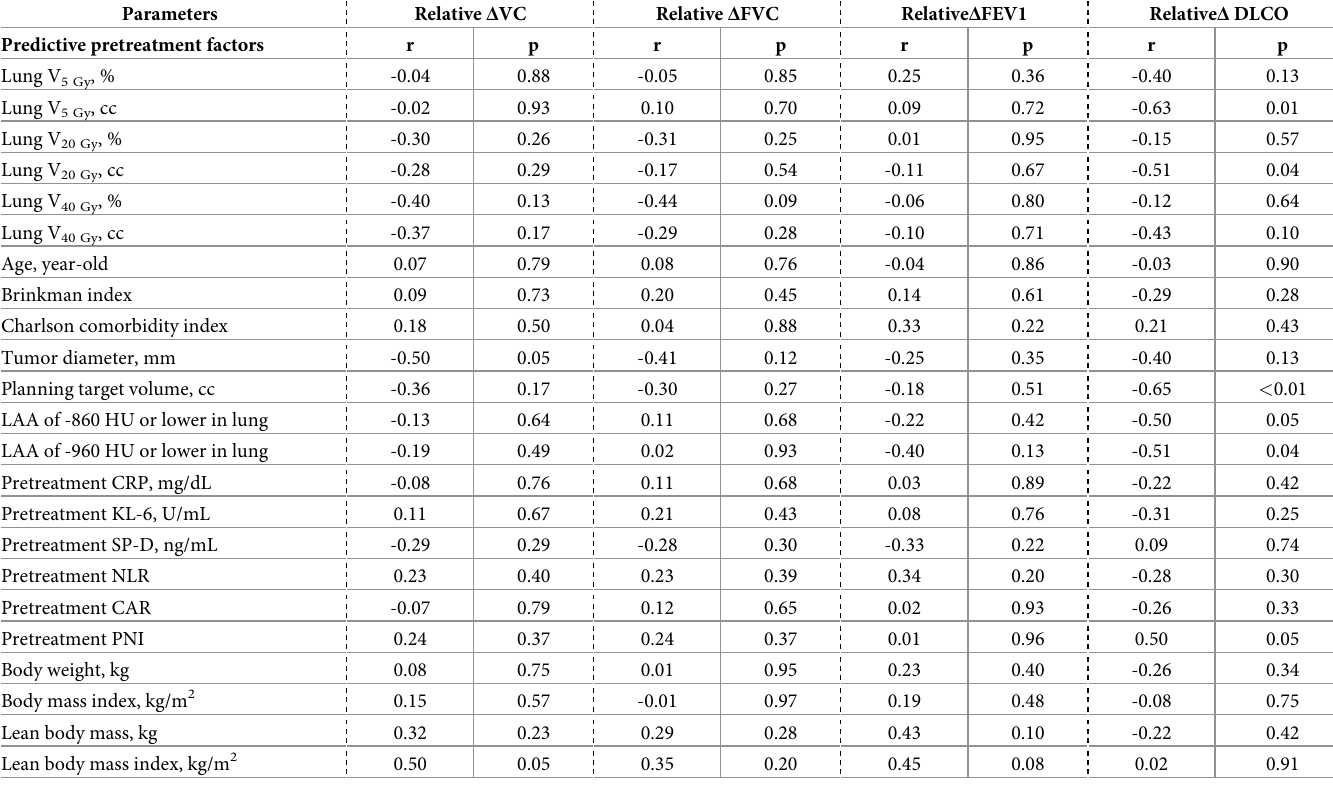
Table 5. Predictive factors of relative parameter changes in pulmonary function tests from baseline to 12 months after SRT.